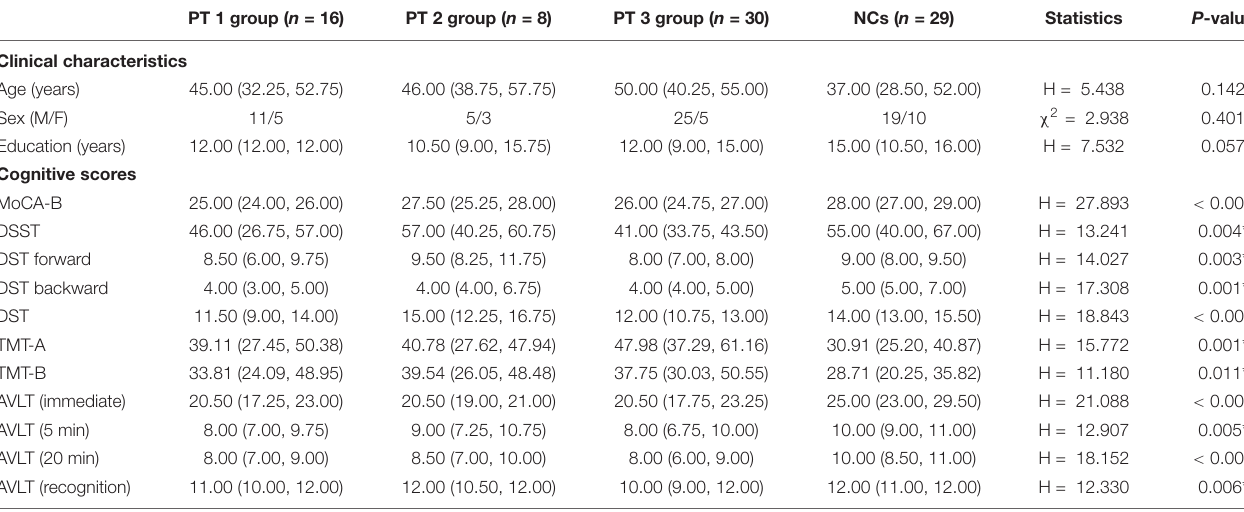
TABLE 1 | Demographics, clinical data, cognitive assessment of NPC patients after RT and